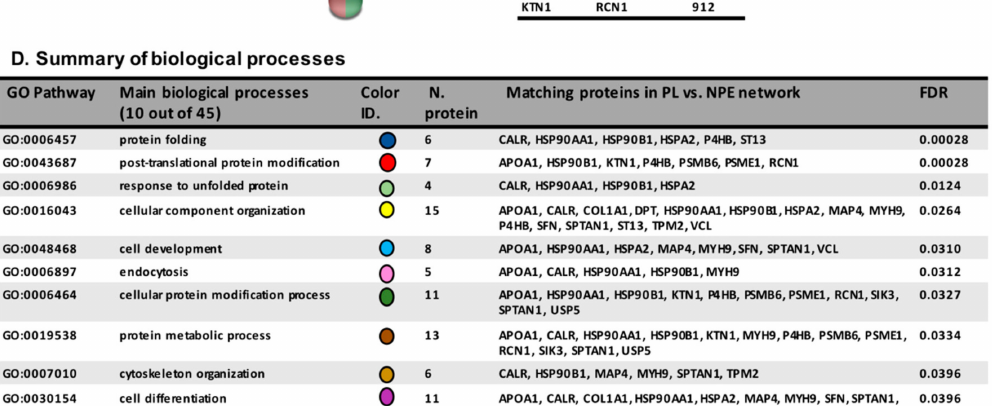
Figure 5. STRING analysis PL vs. NPE. Panel A : Network statistics reporting data concerning the number of nodes and edges, the average node degree, the average local clustering coe ffi cient, the expected number of edges and the PPI enrichment p -value. Panel B : Network interaction image showing nodes and edges between the proteins identified. The thickness of the line indicates the strength of the interaction between the proteins. The colours of the sphere indicate the biological processes to which the protein belongs. Panel C : Network interaction table reports all the significant interactions (min 0.4) between the protein of the PL vs. NPE network. Panel D : Biological process table reports the main pathways to which the protein of the networks belongs. For each biological process identified, the corresponding Gene Ontology (GO) pathway, the number and identity of proteins and the false discovery rate is